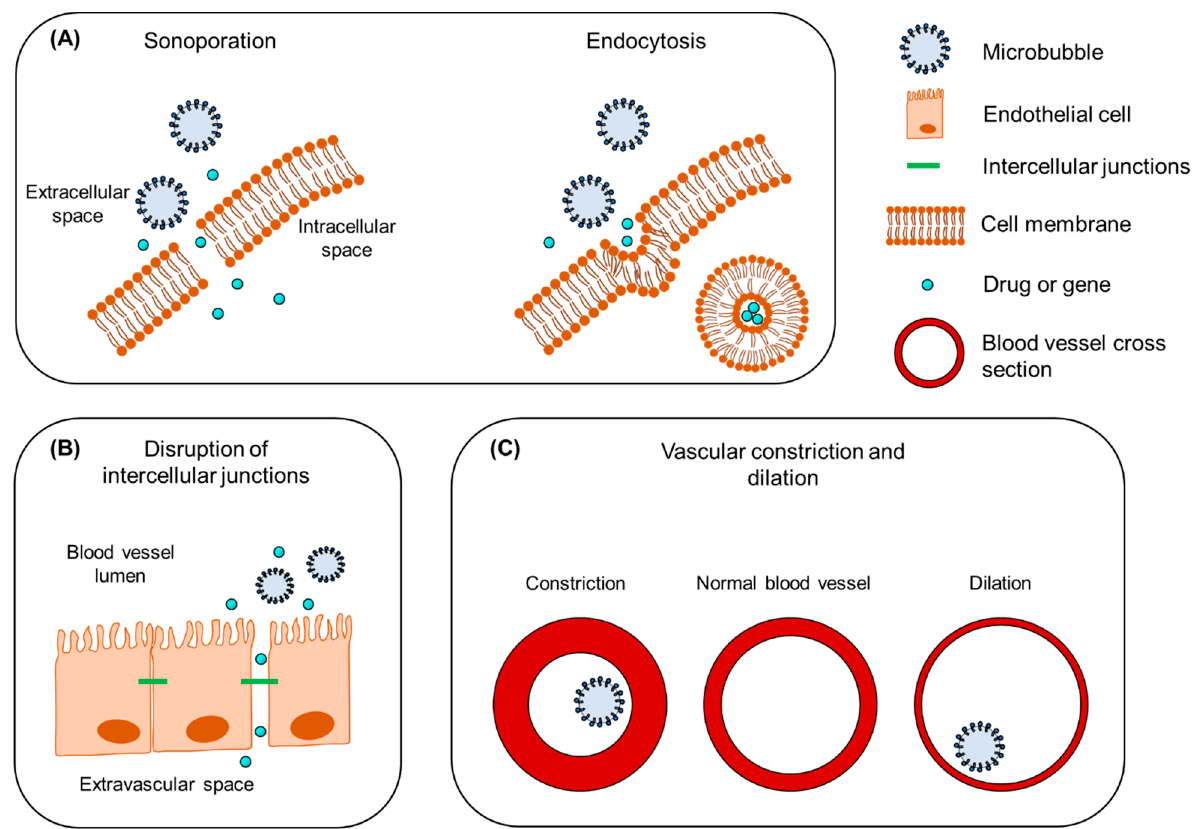
Figure 2. The mechanisms underlying the therapeutic use of USMB. ( A ) Intracellular uptake of drug/gene induced by sonoporation ( left ) and endocytosis ( right ). ( B ) Disruption of intercellular junctions and extravasation of drug/gene from blood vessel to the extracellular space. ( C ) Vascular constriction and dilation. Figure not to scale.